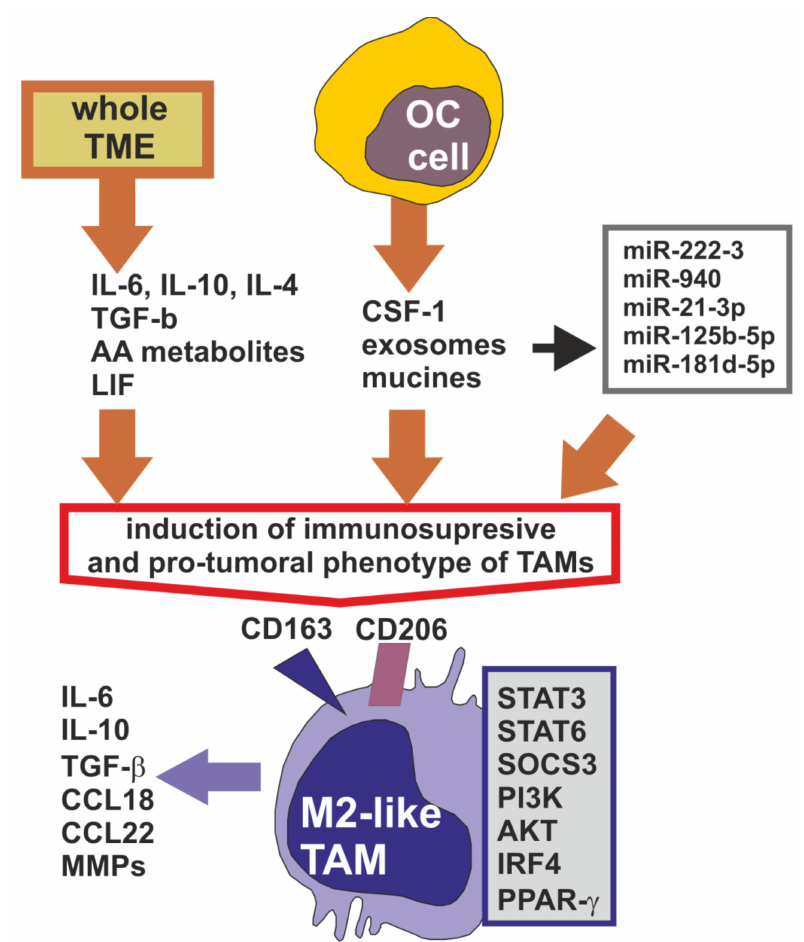
Figure 1. Induction of M2-like TAMs in ovarian cancer tumor microenvironment. The soluble factors (cytokines, chemokines, AA metabolites, mucines and exosomes reach in microRNAs) released by ovarian cancer (OC) cells and other cells of tumor microenvironment (TME) polarize TAMs into immunosuppressive M2-like phenotype. M2-like TAMs characterize with surface expression of CD163 and CD206 receptors, overexpression of various intracellular signaling proteins and production of immunosuppressive and pro-angiogenic and pro-invasion